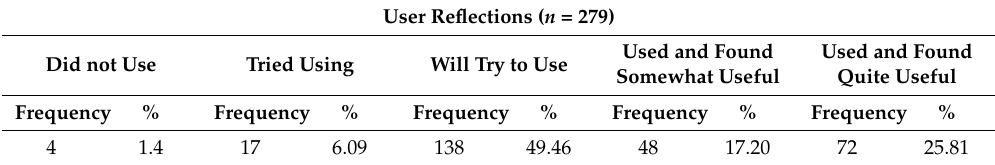
Table 8. Reflection at the beginning of a new section on utilization of what was learnt in the previous